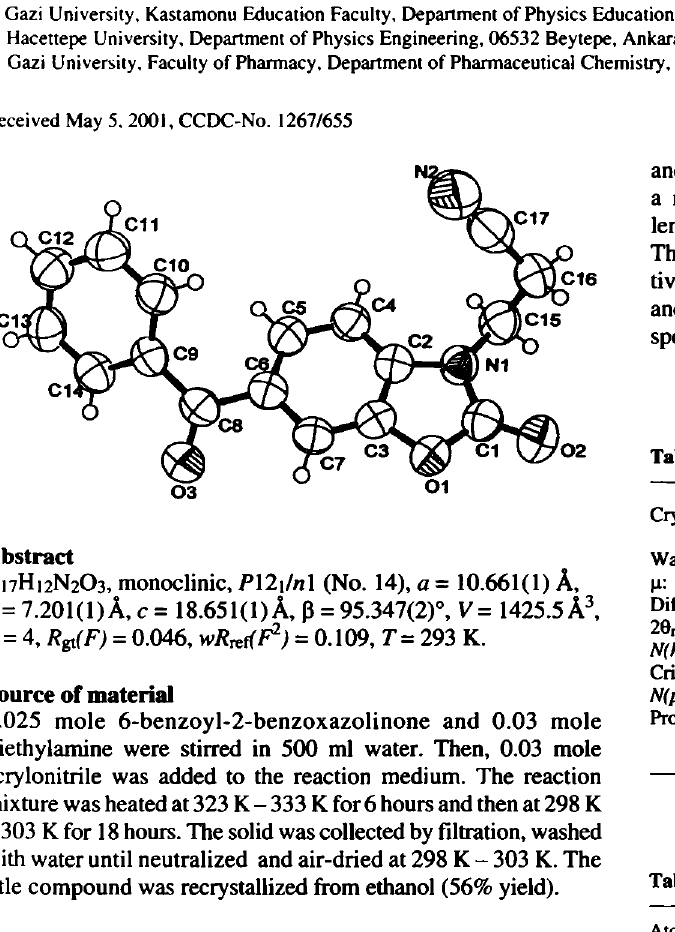
Table 2. Atomic coordinates and displacement parameters (in Ä 2